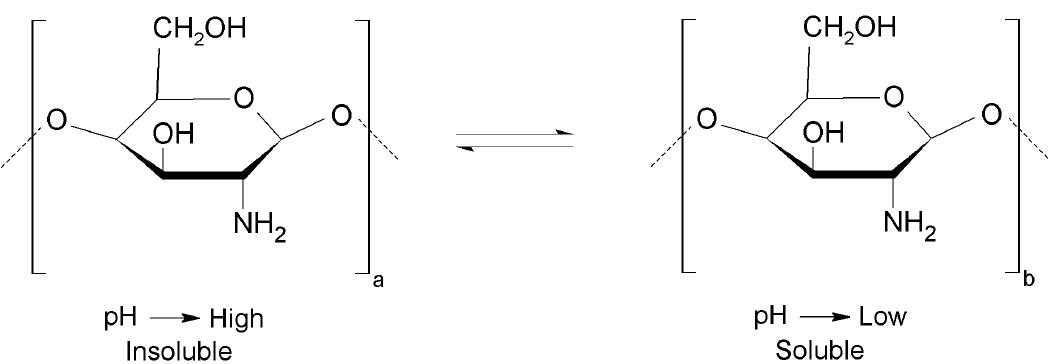
Figure 3. Chemical structure of chitosan as a function of pH. Insoluble (pH > 6) and soluble (pH < 6).